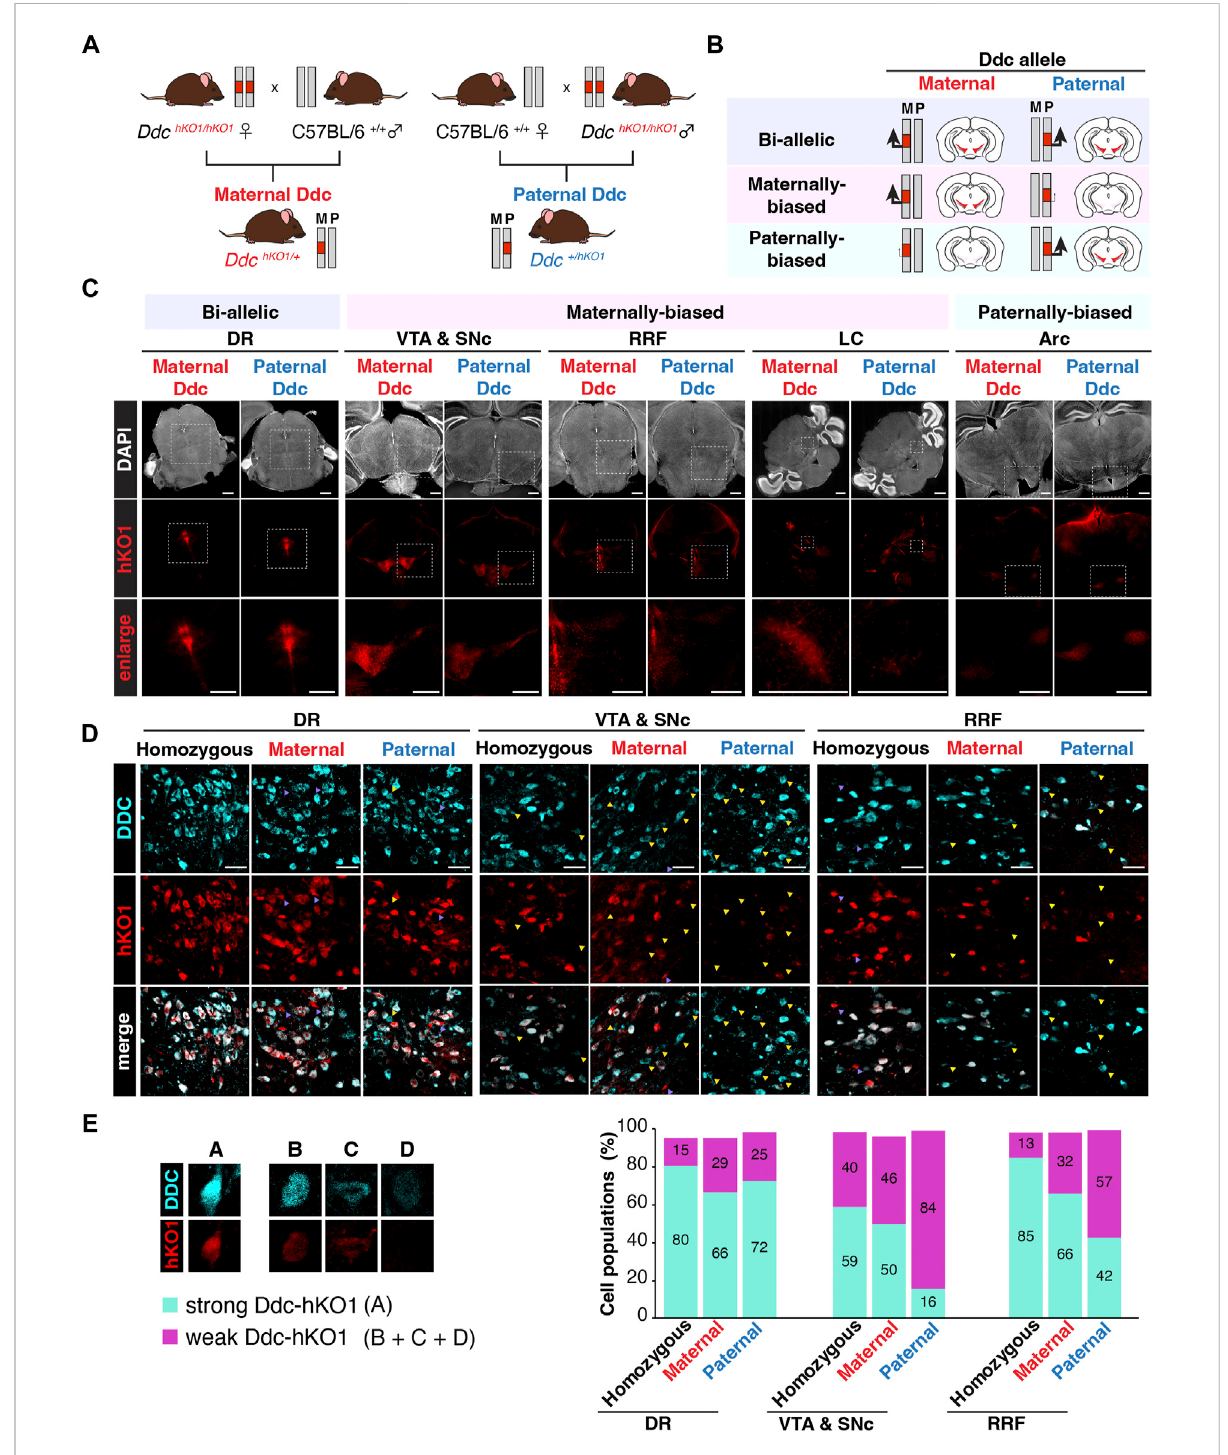
FIGURE 4 Allelic expression of Ddc in the mouse brain. (A) Illustration showing the crosses of Ddc-hKO1 homozygous mouse with wild type mouse to obtain single allele with hKO1 knock-in, either inherited maternally (maternal Ddc ) or paternally (paternal Ddc ) in heterozygous mice for the investigation of the allelic expression of Ddc in the brain. (B) Illustration showing the expected hKO1 expression and fl uorescence intensity signal for each combination of allelic expression pattern in maternal and paternal Ddc . (C) Representative images showing hKO1 expression in Ddc - positive mouse brain regions of maternal and paternal Ddc . Scale bar, 1,000 μ m) (D) Representative images showing DDC immuno fl uorescence (DDC-IF) and Ddc-hKO1 reporter expression in DR, VTA and SNc, and RRF regions of Ddc-hKO1 homozygous, maternally derived and paternally